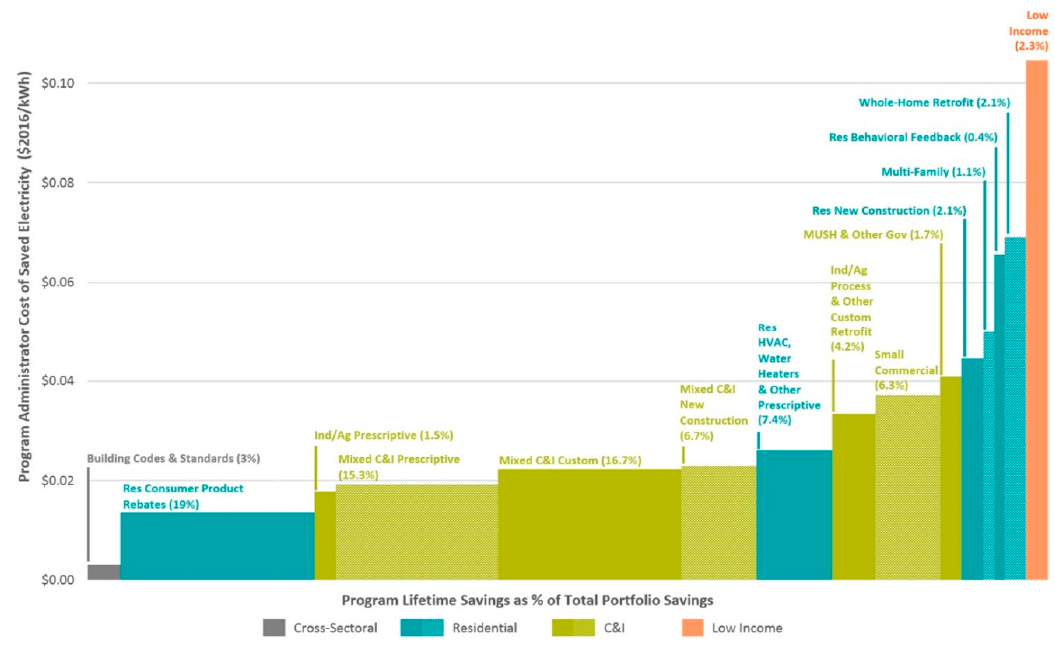
Figure 4. Composite cost curve for electricity efficiency programs funded by utility customers (2009–2015). Ind: Industry, MUSH: Municipal Government, University, K-12 Schools, and Hospitals, Res: Residential.